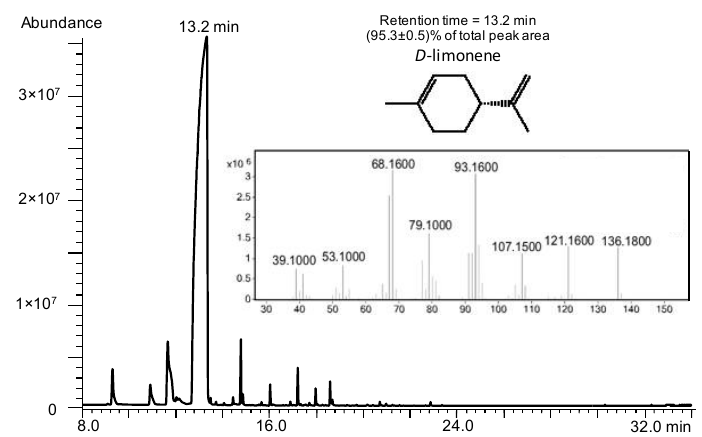
Figure 3. Separation of the volatile components in long-leaf orange peel oil and identification of the major compound D -limonene using GC-MS analysis.